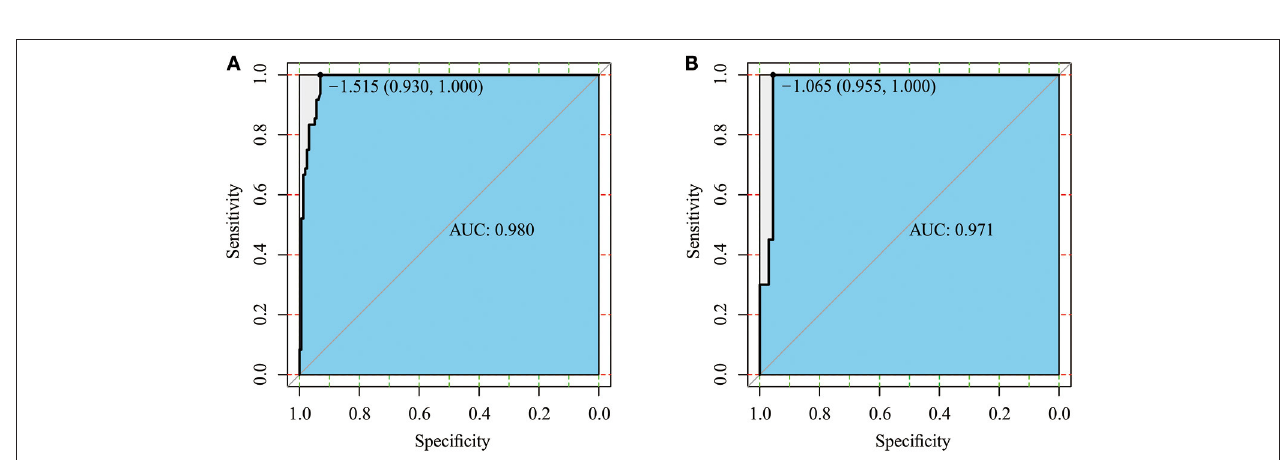
FIGURE 3 | Receiver operating characteristic (ROC) curve of the training set (A) and validation set (B)